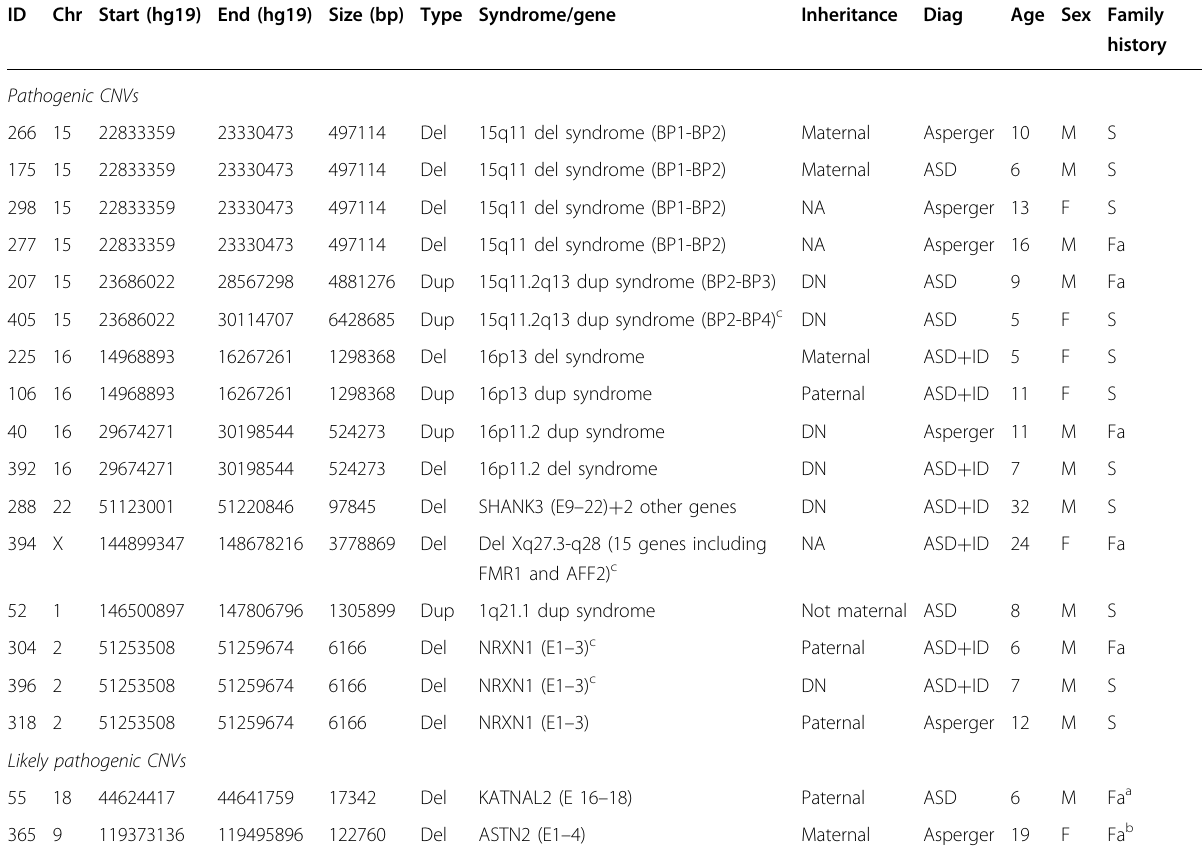
Table 2 CNVs conferring susceptibility for autism identi fi ed among the 253 ASD subjects.